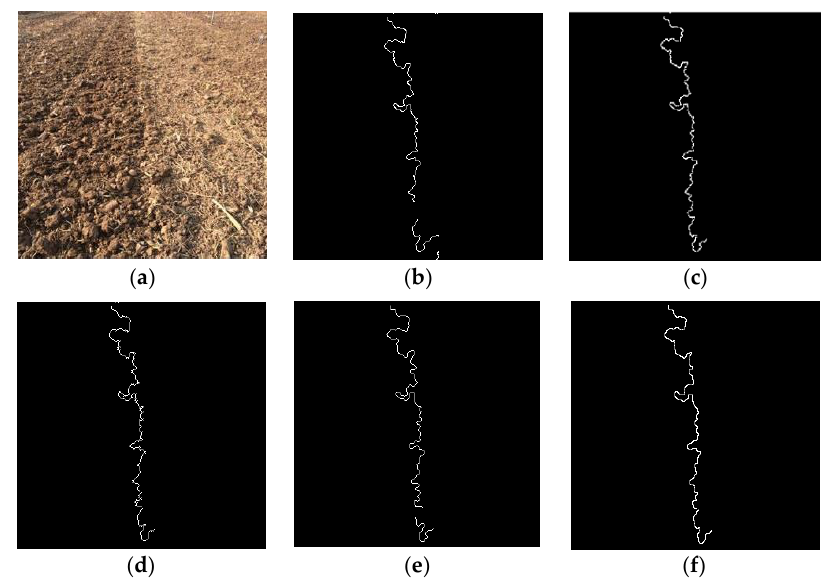
Figure 15. The results of edge detection: ( a ) original; ( b ) Sobel; ( c ) Roberts; ( d ) Prewitt; ( e ) Log; ( f ) improved anti-noise morphology.